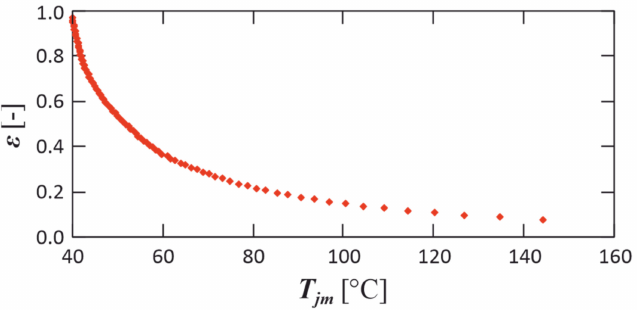
Figure 13. Dependence between the set value of emissivity coefficient ε and the measured semicon- ductor die T jm in the same semiconductor